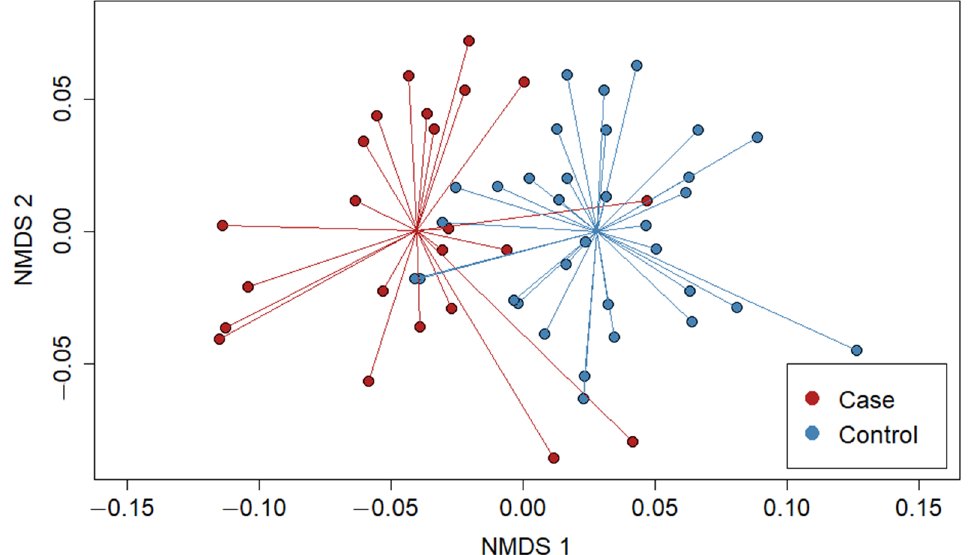
Figure 5. Non-metric multidimensional scaling (NMDS) of bacterial community composition of A. pectorosa at the SV level. Plot shows NMDS axes 1 and 2. Lines connecting points of each group (cases and controls) correspond to group centroids (average coordinates).